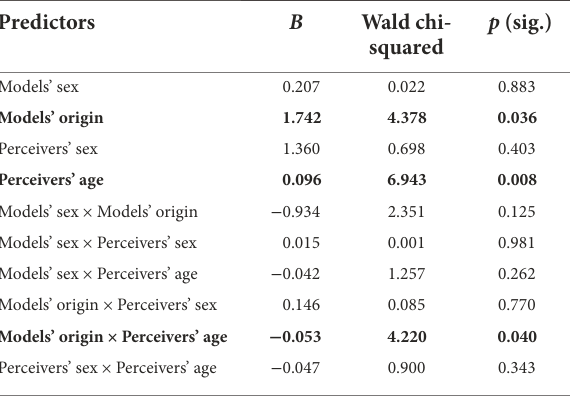
TABLE 2 Effects of models’ sex and origin, and sex and age of perceivers on ability to guess fear. Dependent var.: Guess fear